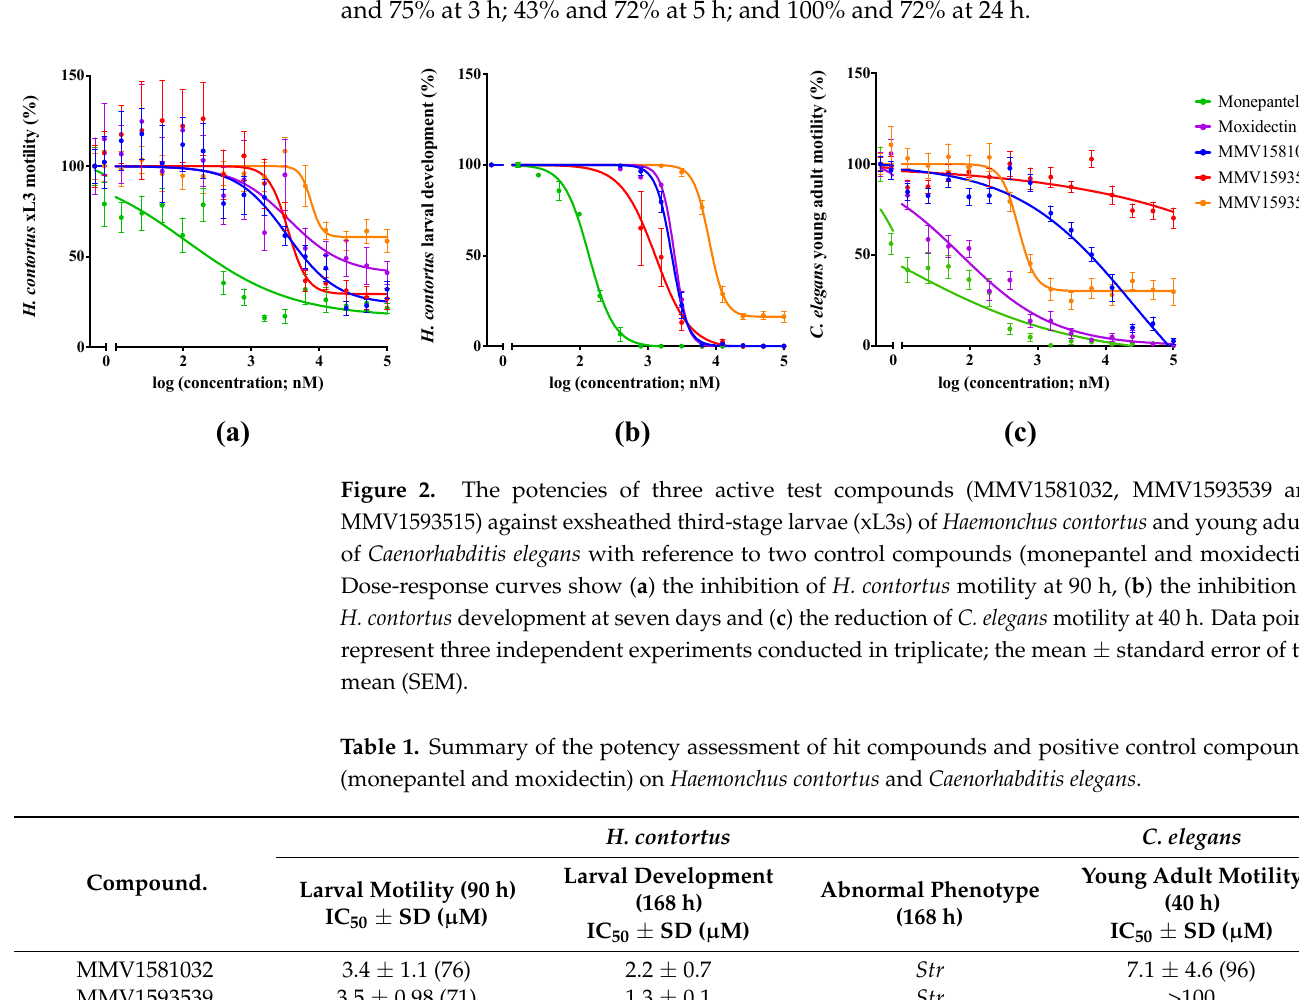
of 1.3 ± 0.11 µ M, values that were comparable to that of moxidectin (IC 50 = 2.4 µ M). MMV1581032 was also evaluated for motility inhibition on adult females of H. contortus (Figure 3). MMV1581032 reduced the motility of these worms by ~0%, 22%, 33%, 63% and 100% over the time course of 1 h, 2 h, 3 h, 5 h and 24 h, respectively. Respective values for IC 50 calculated from three independent assays conducted in triplicate. Value in parentheses repre- monepantel and moxidectin (Figure 3) were: 22% and 67% at 1 h; 22% and 67% at 2 h; 33% sents the maximum motility inhibition (%). Str , straight; – , no apparent distinction from wild-type, and 75% at 3 h; 43% and 72% at 5 h; and 100% and 72% at 24 h. but reduced motility; Coi , coiled; Cur , curved.